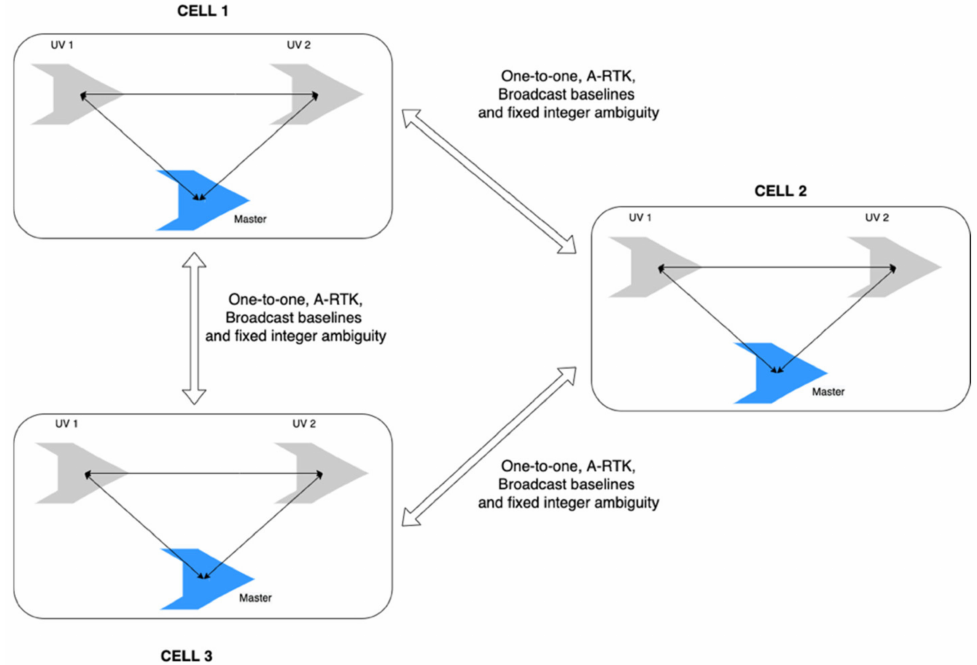
Figure 2. RTK process among three cells realized by the one-to-one RTK or antenna array-aided RTK (A-RTK) between the masters in the cells. The baselines among the UVs across the cells are computed with a broadcast of resolved fixed-integer